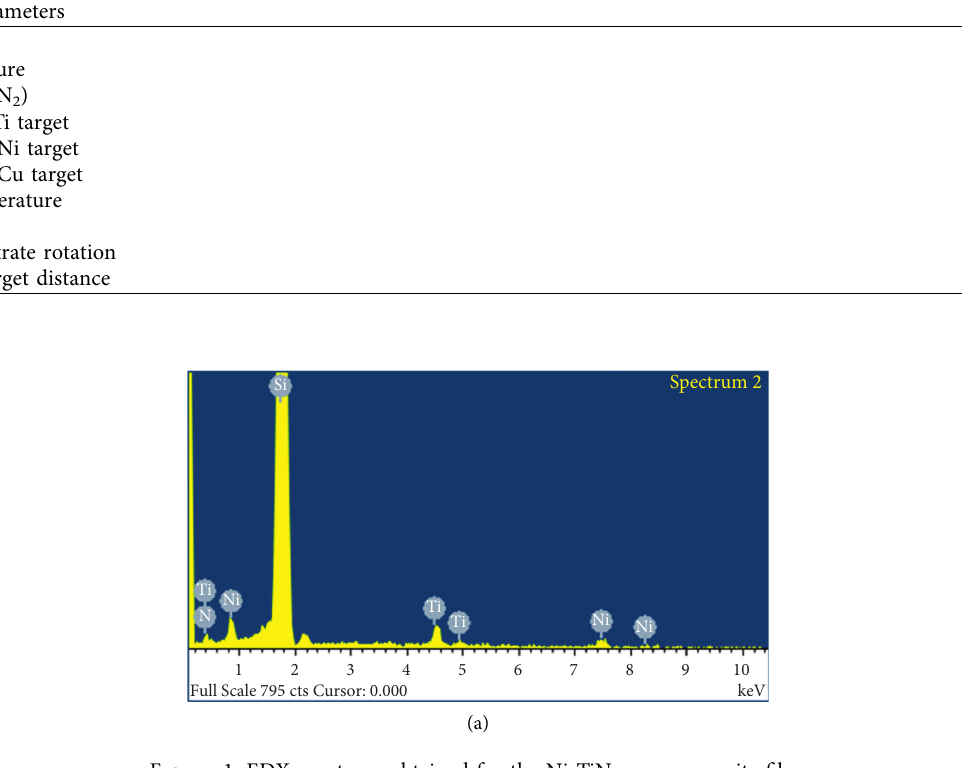
Figure 1: EDX spectrum obtained for the Ni-TiN nanocomposite film.